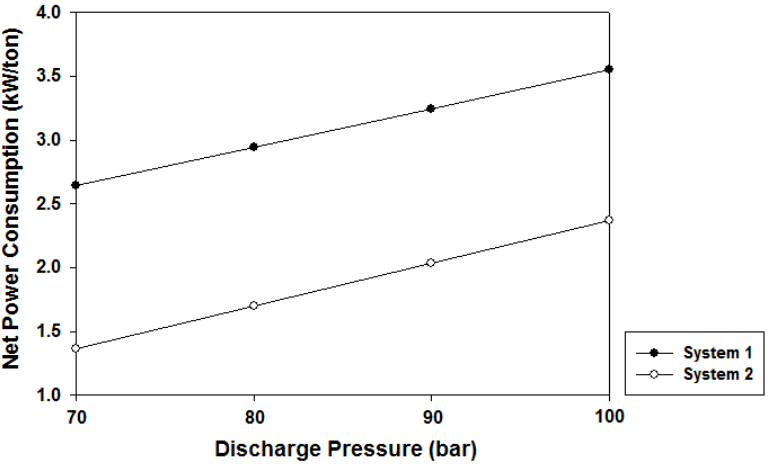
Figure 8. Specific net power consumption at different discharge